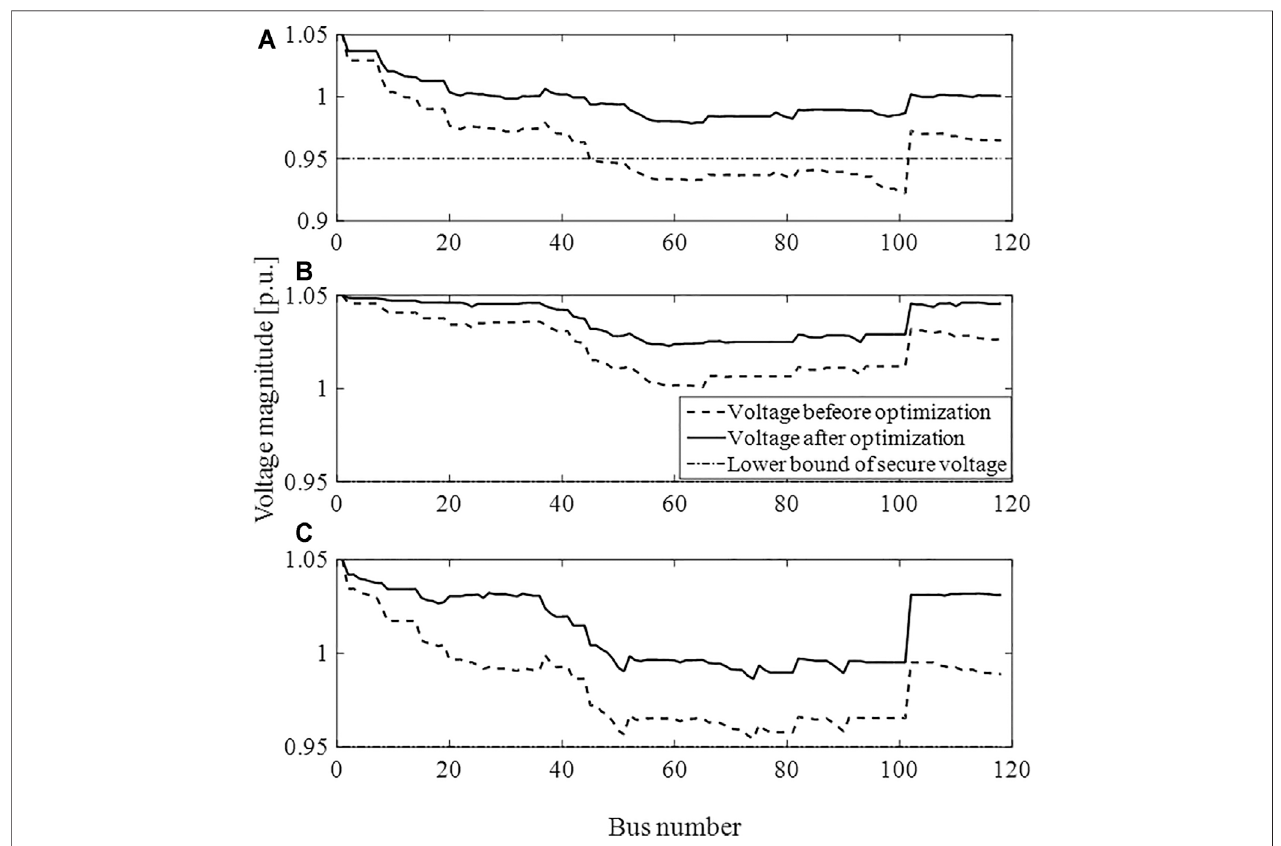
FIGURE 3 | Voltage magnitude comparison between before and after optimization: (A) phase A, (B) phase B and (C) phase C.